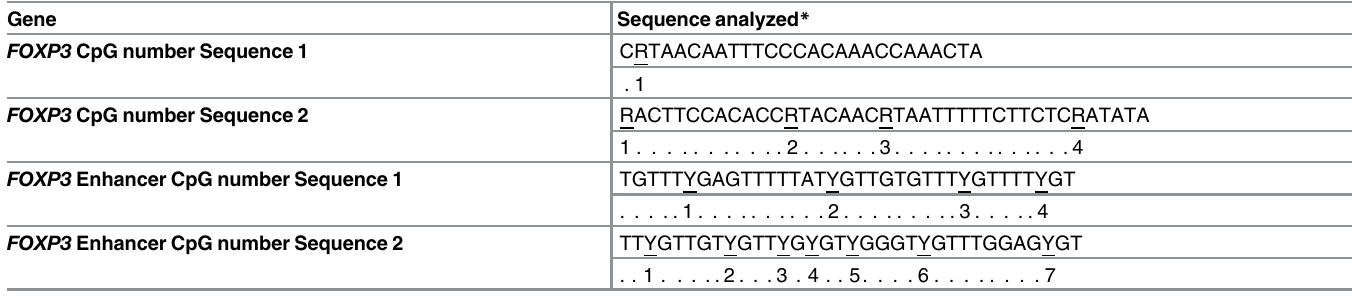
Table 3. Sequences analyzed by bisulfite